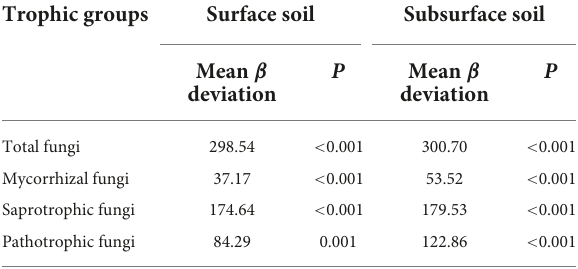
TABLE 1 One-sample two-sided t-test was used to compare mean β deviation against zero for total, mycorrhizal, saprotrophic and pathotrophic fungi in surface and subsurface